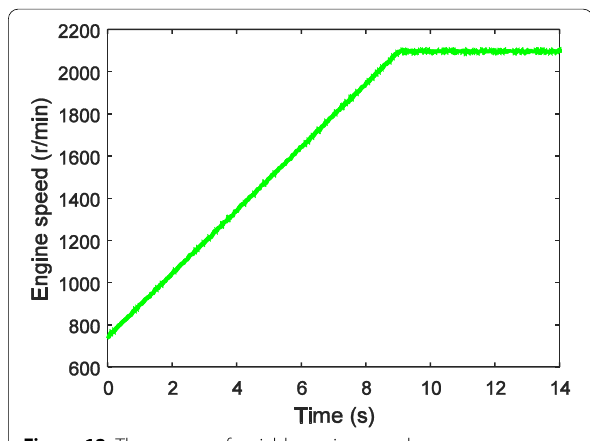
Figure 12 The process of variable engine speed